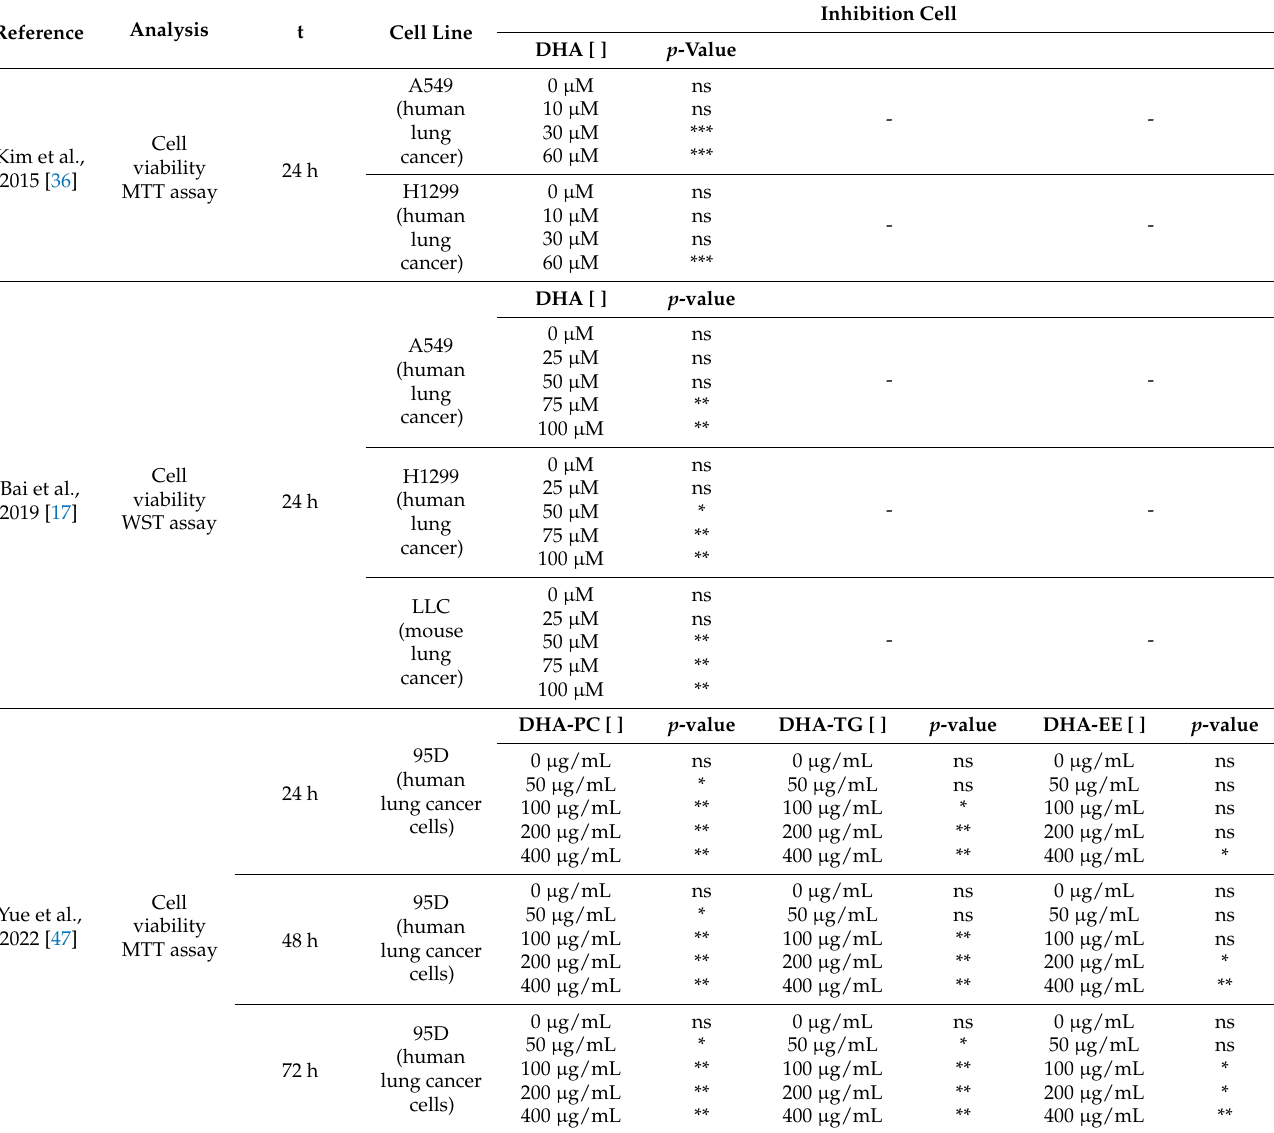
Table 3. Analysis results of the in vitro cytotoxicity tests on lung cancer cell